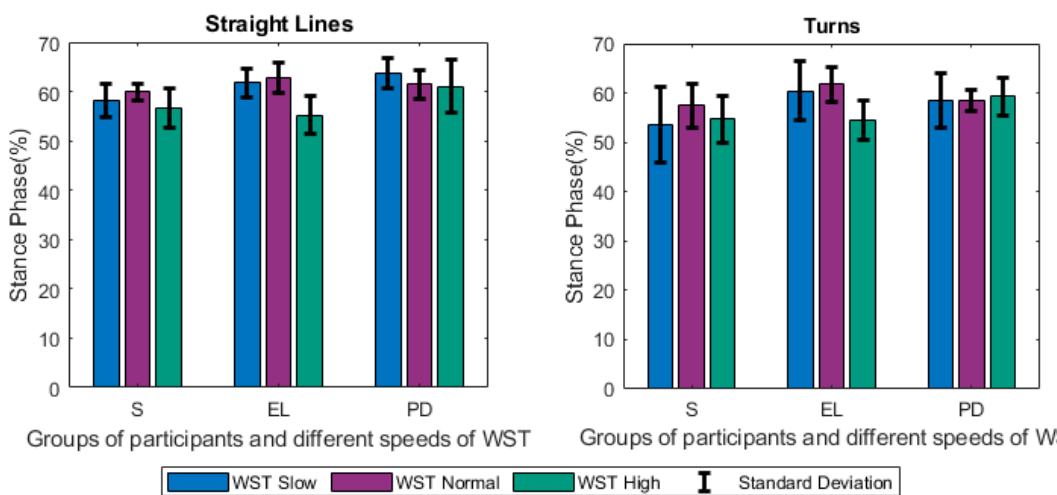
Figure 6. Changes of the Stance Phase (%) for Straight Lines and Turns (mean values along with standard deviations) between the different groups of participants (S, EL, PD) and the different speeds of the WST test (slow, normal, high).